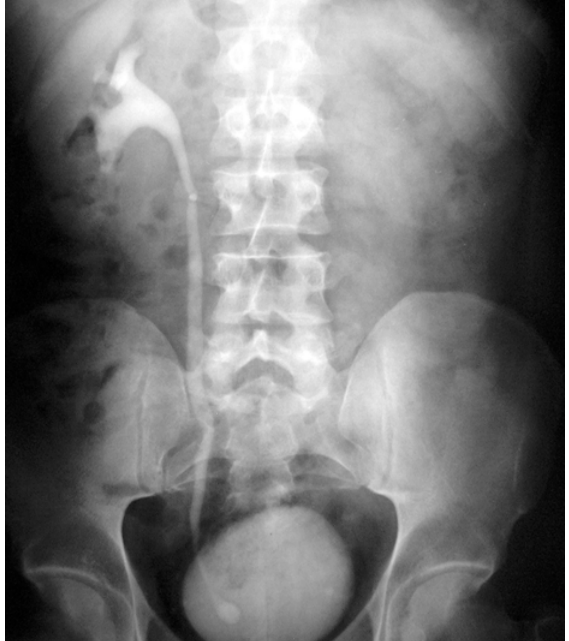
FIGURE 1 . IVU demonstrating single right